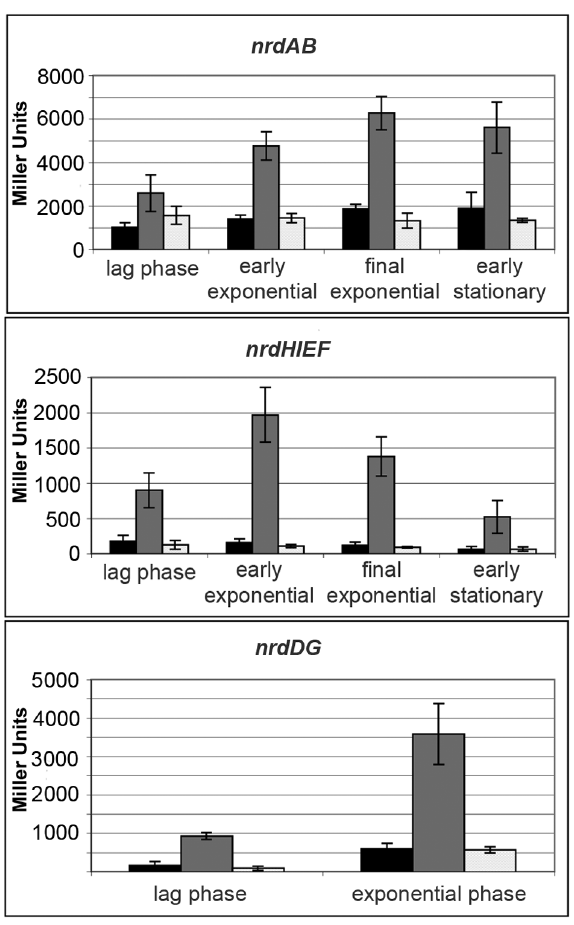
Figure 1. NrdR-dependent expression of RNR. NrdR regulation of S. Typhimurium LT2 RNR expression throughout the growth curve (early exponential (OD 550 =0.2), final exponential (OD 550 =0.8), early station- ary phase (OD 550 =1.4)). b -galactosidase activity of nrdAB , nrdHIEF , and nrdDG promoter regions fused to lacZ expressed in Miller Units (MU). Wild-type strain shown in black, nrdR mutant strain in dark grey, and nrdR mutant complemented strain in light grey. Results are the mean values of duplicates of at least three independent experiments. Error bars represent the standard deviation of experiments.